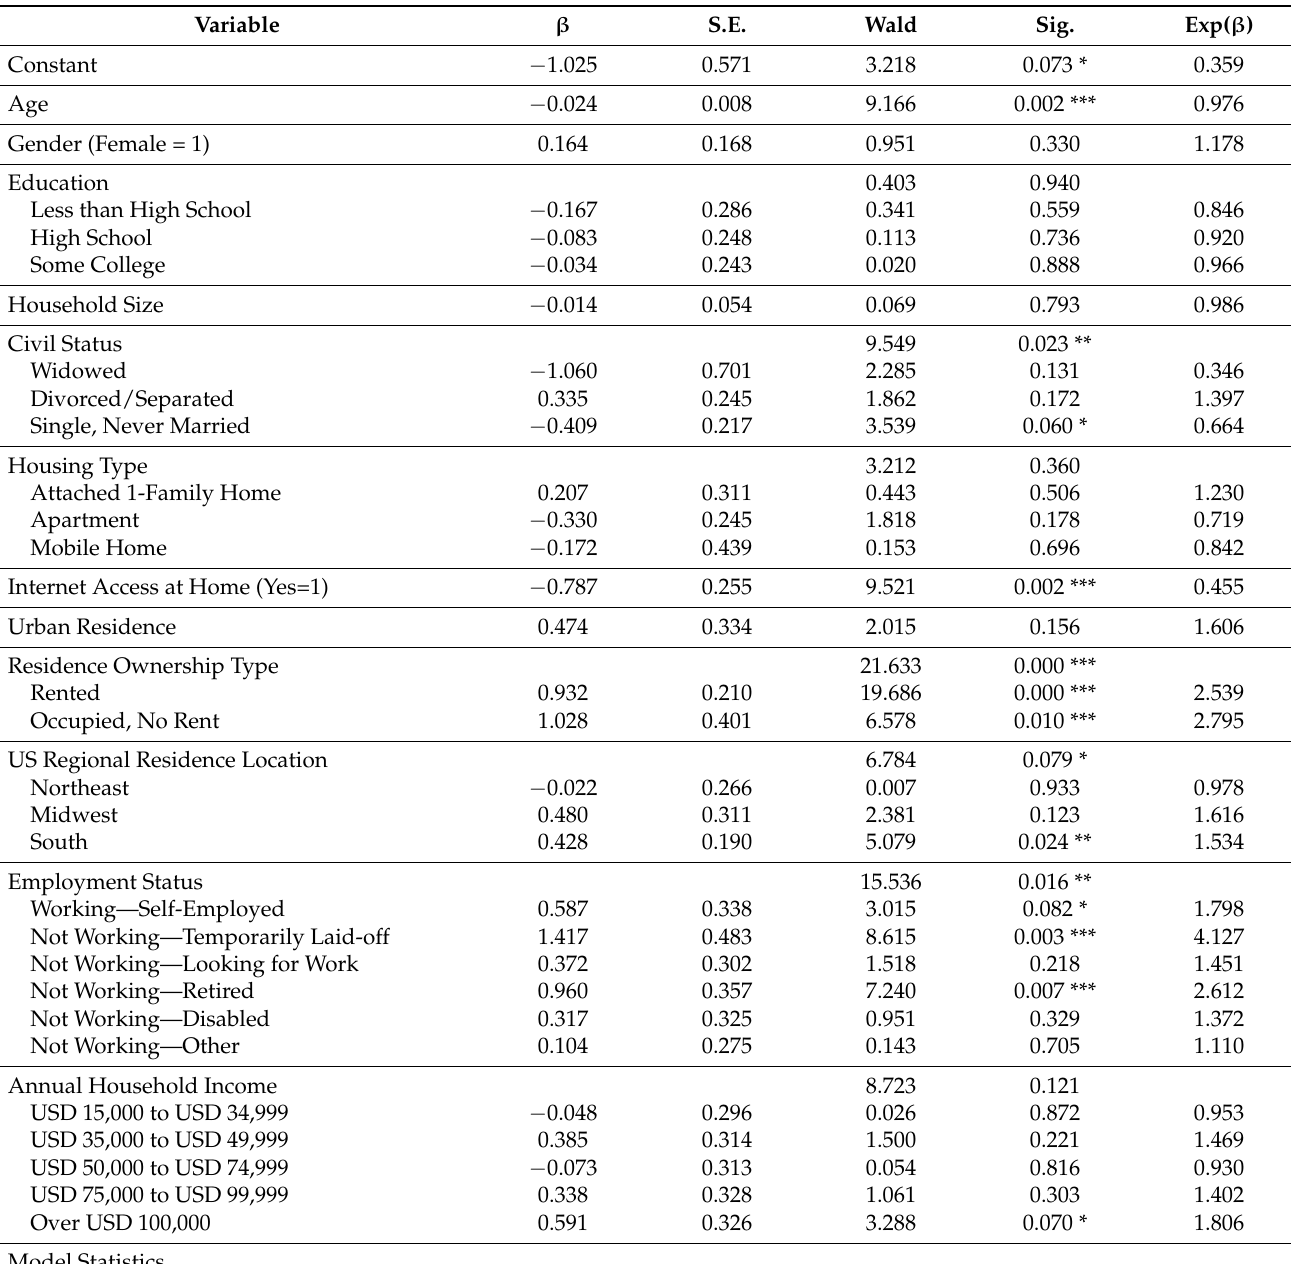
Table A2. Logistic Regression of Hispanic EIWA Online and Online Sharing Economy (Online and Sharing Economy = 1). Variable